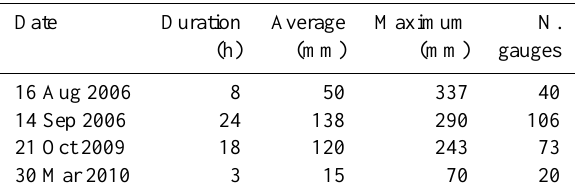
Table 2. Test events characteristics. The average accumulated rain- fall is calculated as the mean of the accumulated rainfall over the entire event for every rain gauge. The maximum accumulated rain- fall is the maximum accumulated rainfall measured by a rain gauge. N. gauges is the number of rain gauges that measured a precipitation greater than 2mm over the event.